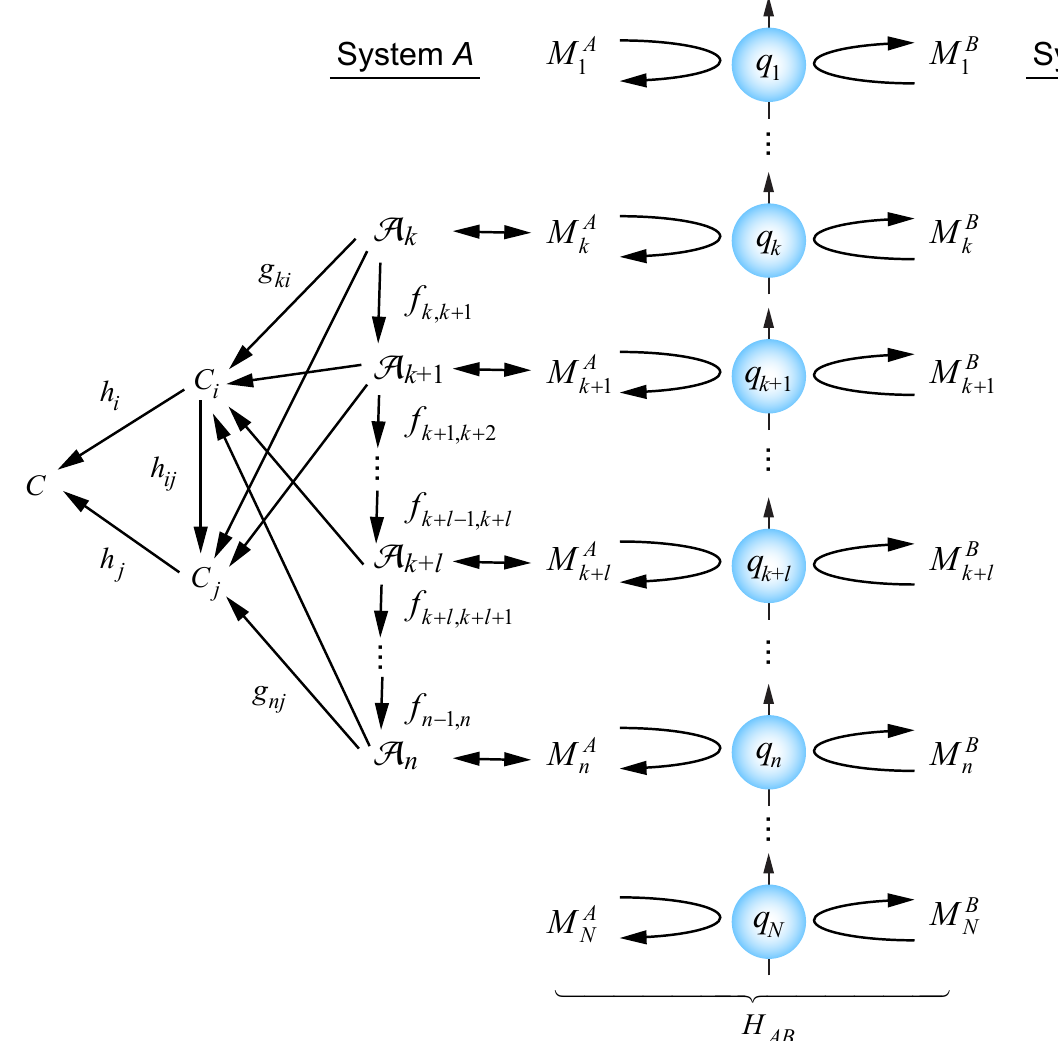
Figure 3: Attaching a Cone-Cocone Diagram (CCCD) to a subset of measurement operators M A binary eigenvalues of the M A with binary inputs to the A i . Only the incoming arrows are shown for simplicity; adding equivalent i but reversed outgoing arrows completes the CCCD. The CCCD specifies a function computed by the internal dynamics H A , i.e. a quantum reference frame (QRF) deployed by A. Adapted from